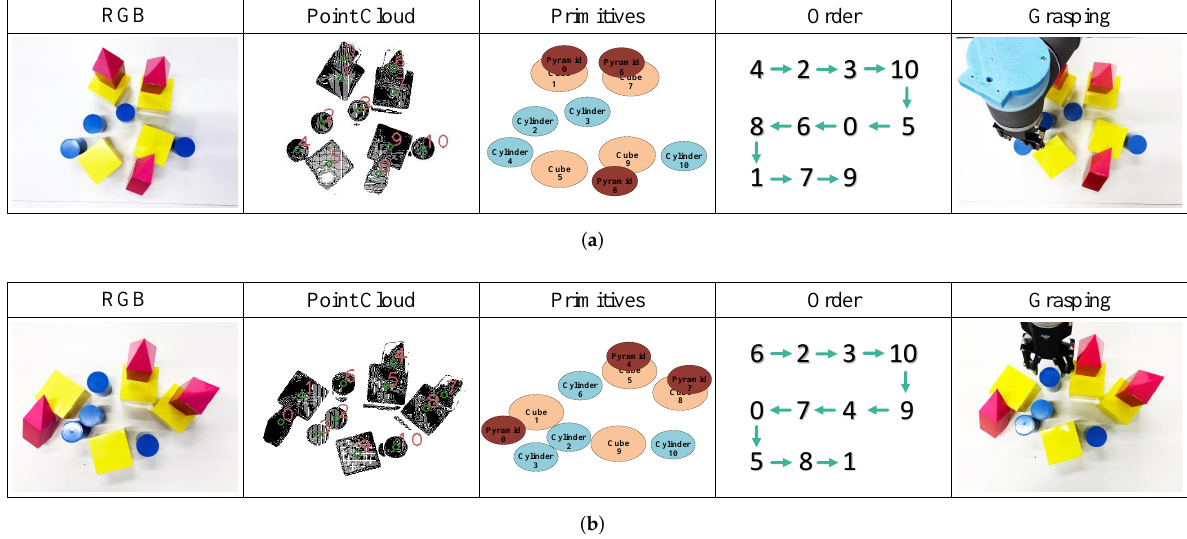
Figure 10. Grasping order planning test on stacked objects in two scenes. ( a ) The first scene; ( b ) The second